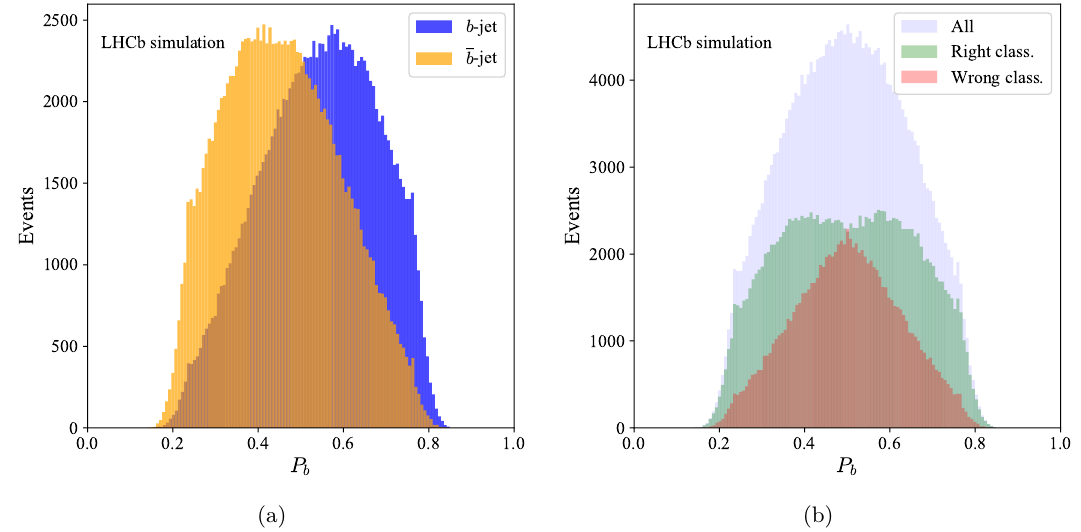
¯ b quarks (yellow), showing